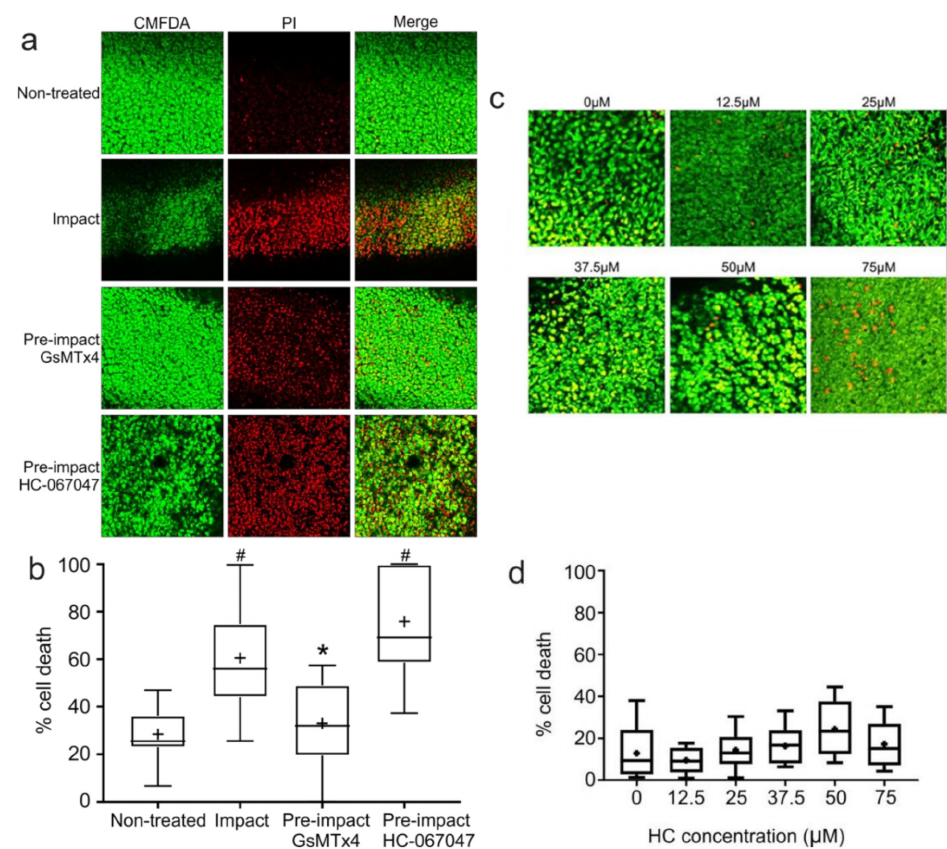
Figure 5. TRPV4 is not associated with impact-induced cell death. ( a ) Representative images of explants 72 h following impact treated with GsMTx4 or HC-067047 prior to impact. Live cells stained with CMFDA (green) and dead cells with PI (red). ( b ) Quantification of percentage cell death from impact experiments shown in ( a ) ( n = 6 explants, 5 fields of view/explant; # = p < 0.01 vs. non-treated, * = p < 0.01 vs. impact). ( c ) Representative images of explants 72 h following treatment with increasing doses of HC-067047. Live cells stained with CMFDA (green) and dead cells with propidium iodide (red). ( d ) Quantification of percentage cell death from experiments shown in ( c ) ( n = 3 explants, 3 fields of view/explant). There were no significant differences between levels of cell death in any